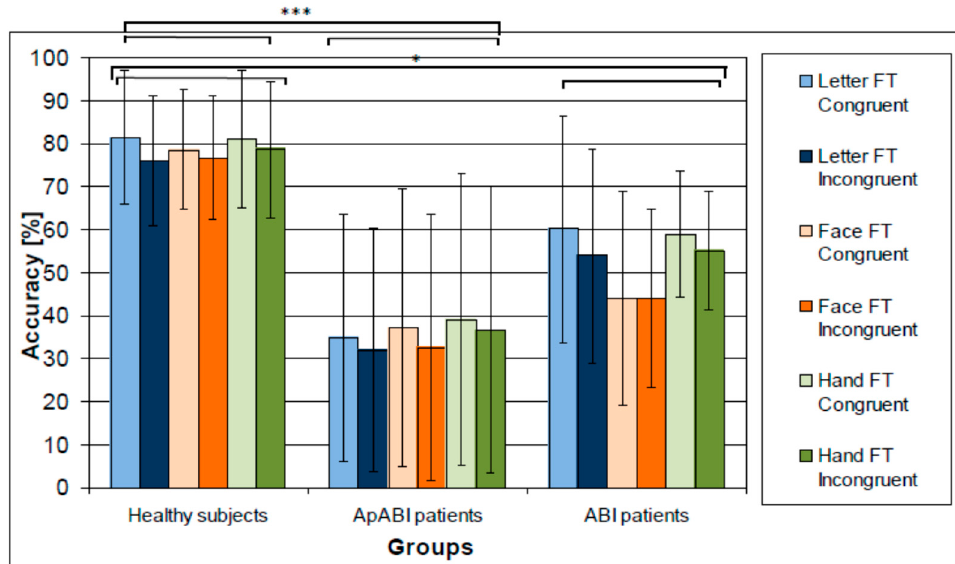
Figure 4. Mean of the ACC (higher values correspond to better accuracy) for healthy subjects, and ABI patients in the letter (blue), face (orange), and hand (green) FT, and in congruent (light color) and incongruent (dark color) trials. * stands for p ≤ 0.05; *** stand for p ≤ 0.001.